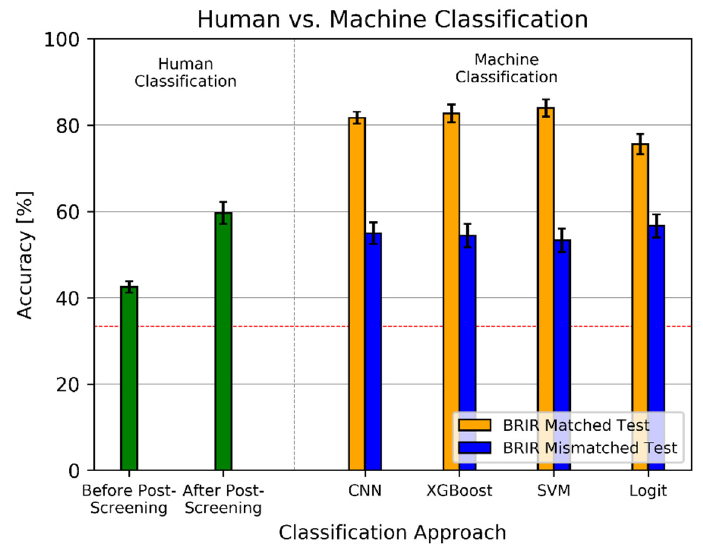
Figure 7. Comparison of human against machine classification of spatial audio scenes. Red line denotes no-information rate. Error bars represent 95% confidence intervals.